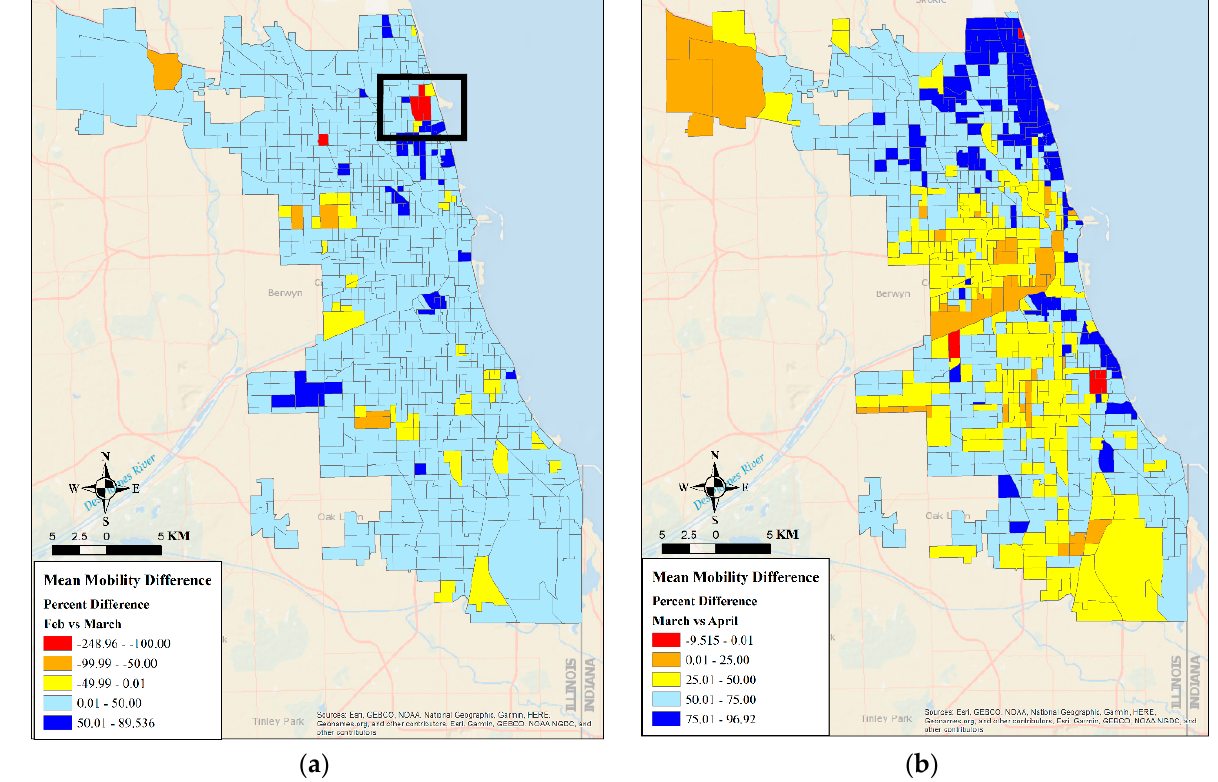
Figure 8. Mean mobility percent difference in Chicago between February and March ( a ) and between March and April ( b ).